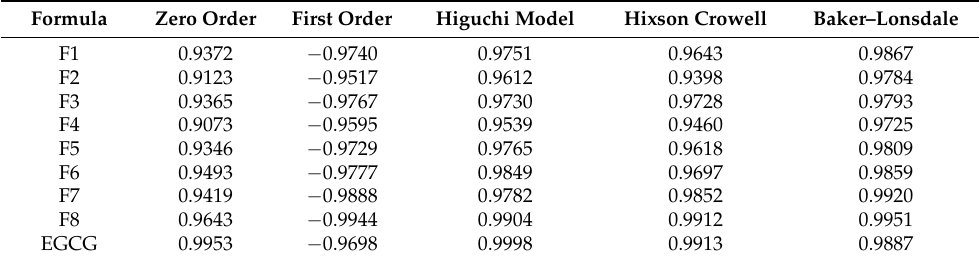
Table 4. The calculated correlation coefficients for the in vitro release of EGCG and EGCG-loaded spanlastics employing different kinetic